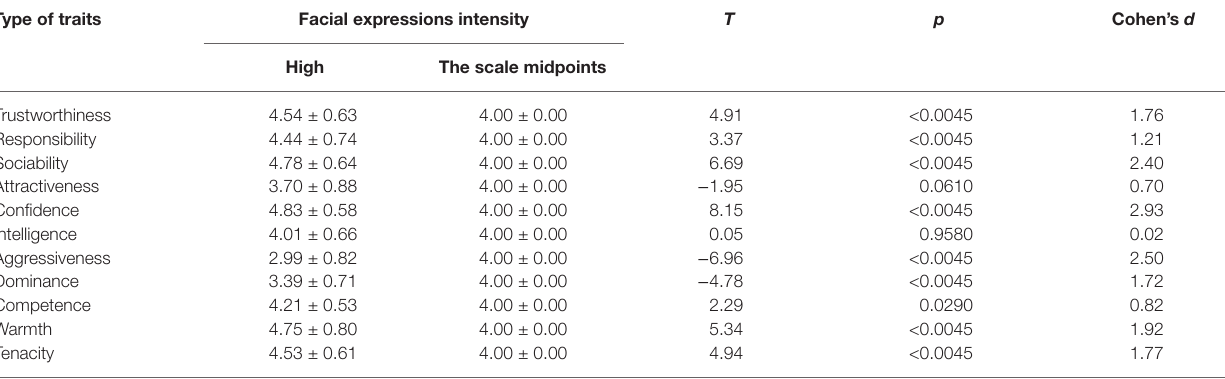
TABLE 7 | Evaluation scores for the traits under high-intensity happy expression and scale midpoints (M ± SD). Type of traits Facial expressions intensity T p Cohen’s d High The scale midpoints Trustworthiness